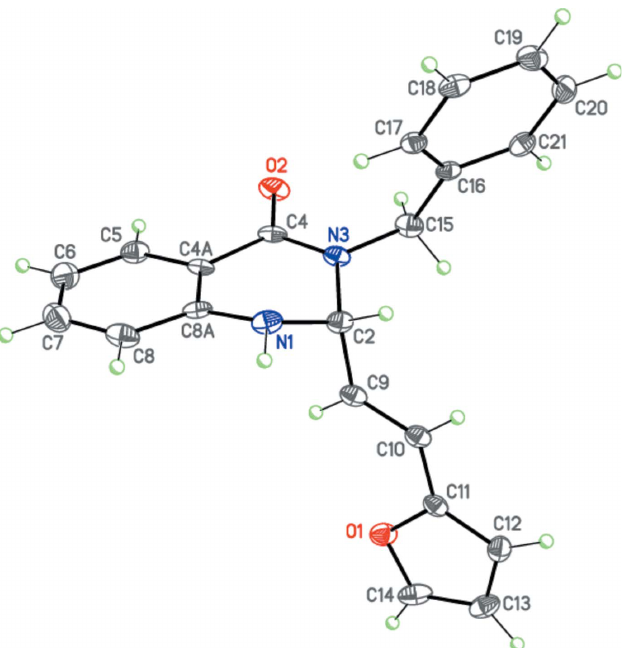
Figure 2 The molecular structure of (I). Displacement ellipsoids are shown at the 50% probability level. H atoms are presented as small spheres of arbitrary radius.